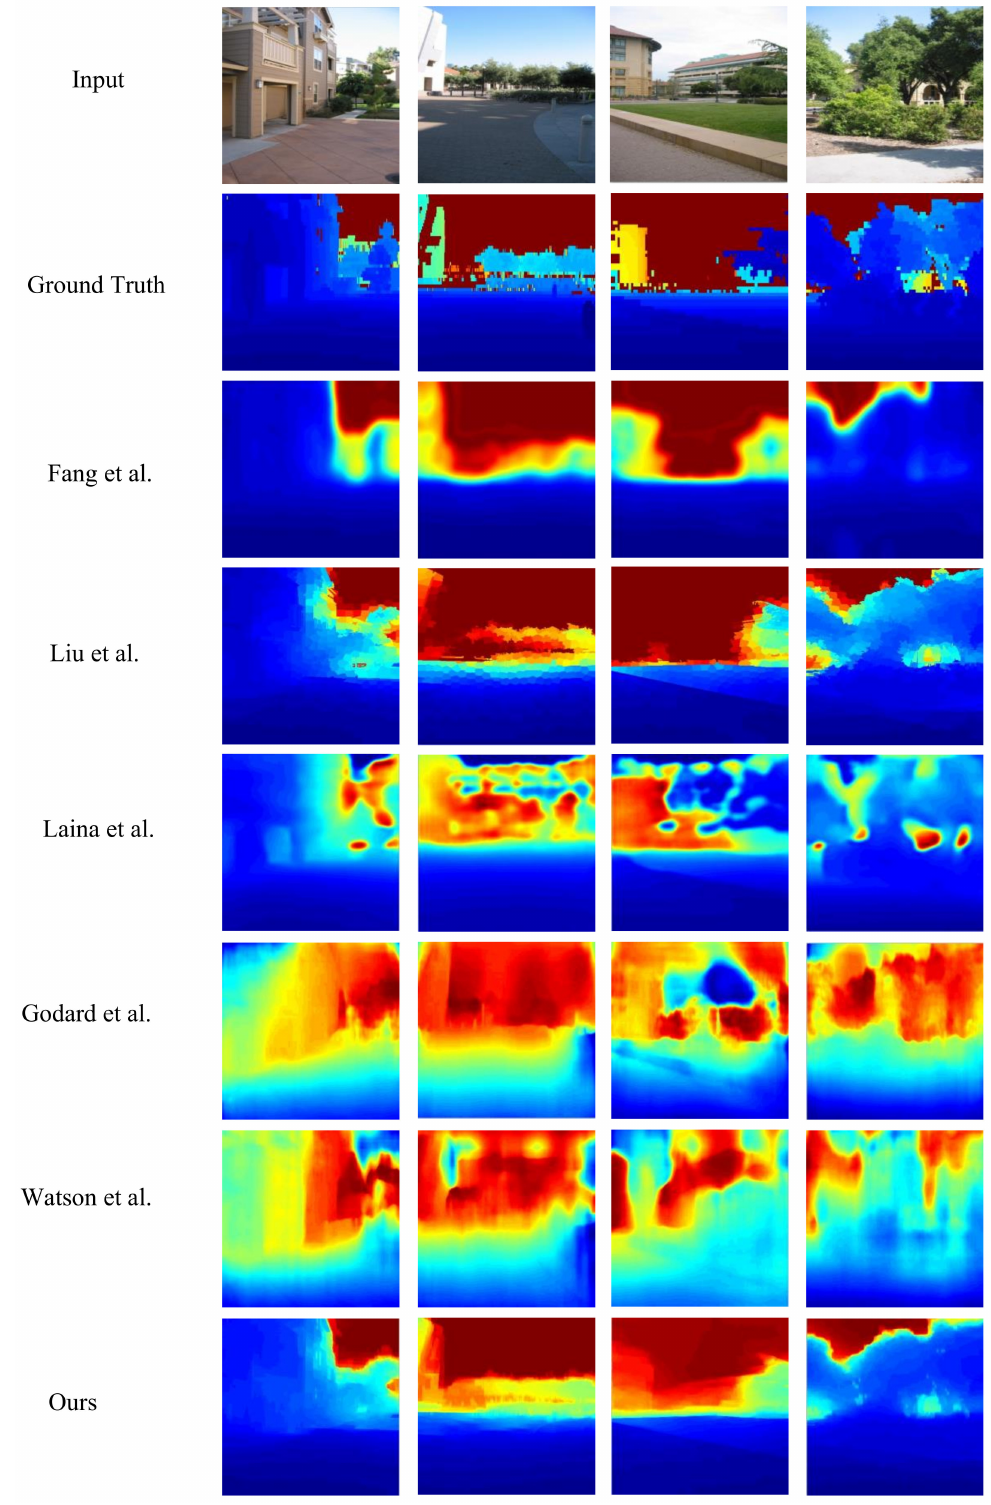
Figure 8. Assessment results on the Make3D dataset. First row: input, second row: ground- truth, third row to last row: depths recovered by Fang et al. [58], Liu et al. [21], Laina et al. [5], Godard et al. [29], Watson et al. [30], and our